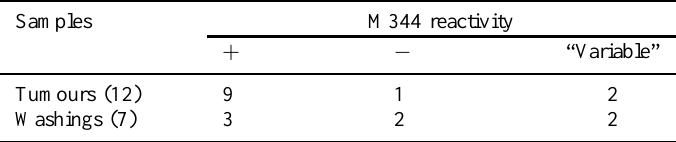
Table 2 M344 tumour antigen expression in bladder washings and tumour